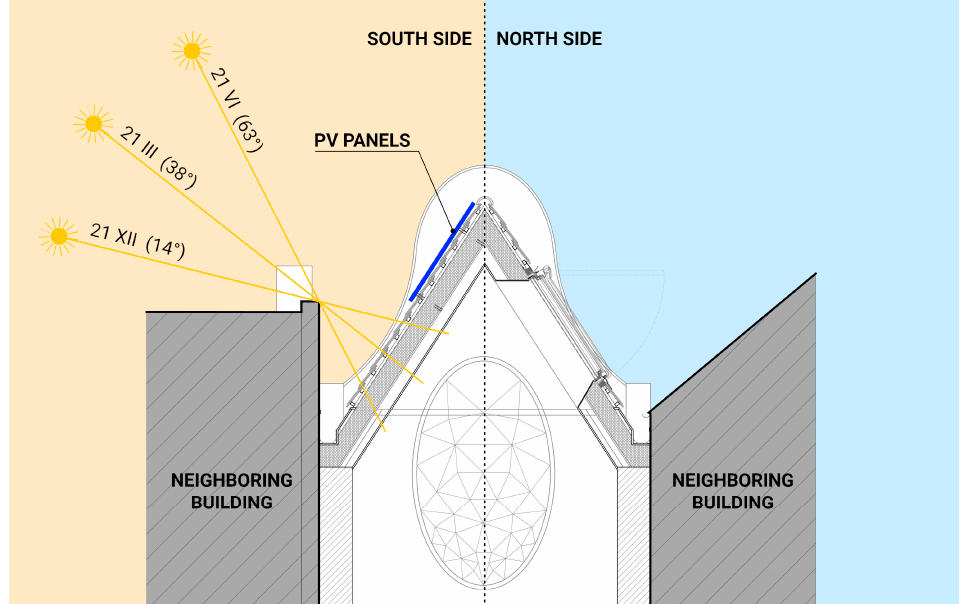
Figure 13. Incident angles of sunlight on PV panels in periods that are representative of the whole year.